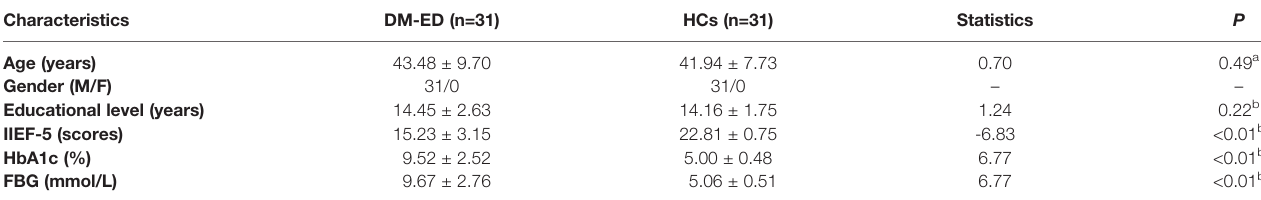
TABLE 1 | Demographic and clinical characteristics of DM-ED and HC